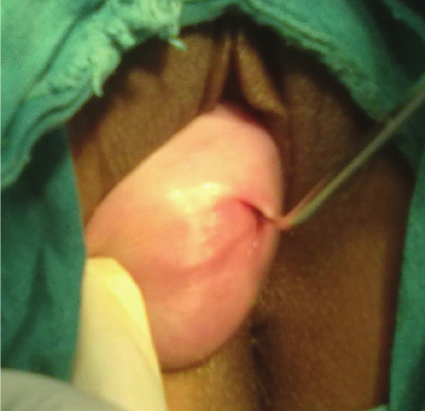
Figure 1: Third-degree cervical descent with a cyst inside on left side and external os (shown by a uterine sound).